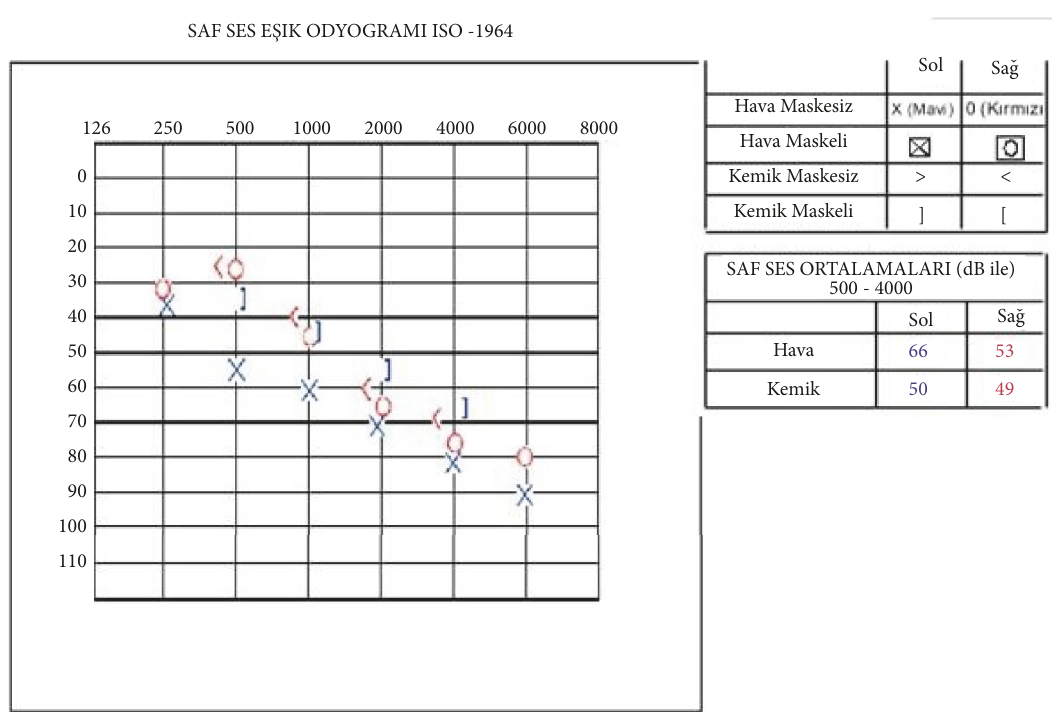
Figure 1: Pure tone threshold audiogram shows a moderate mix type in the left ear and sensorineural hearing loss in the right ear at slightly higher frequencies.